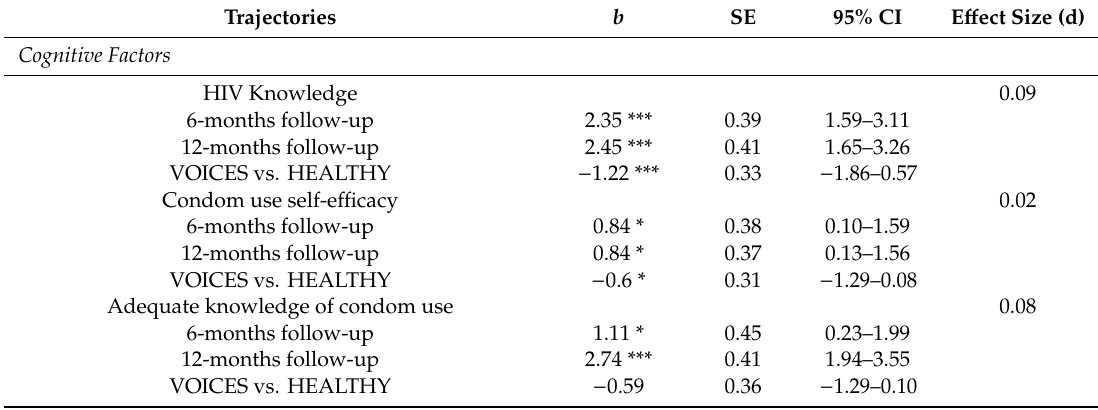
Table 2. Intervention e ff ects on cognitive, behavioral, and communication